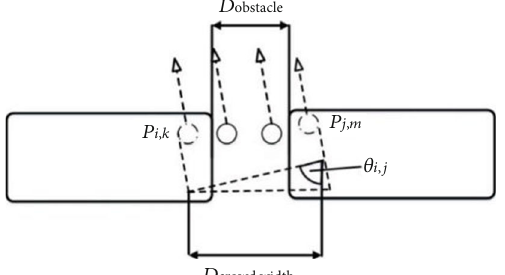
Figure 9: When the width of the population is greater than the width of the intersection.